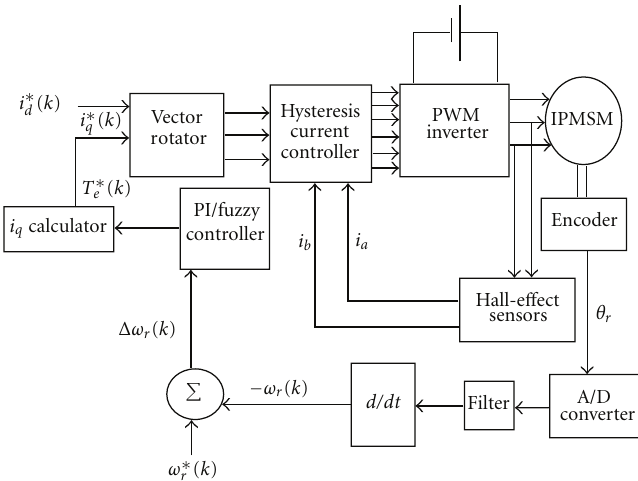
Figure 2: Block diagram of flux-weakening speed control of IPMSM drive.